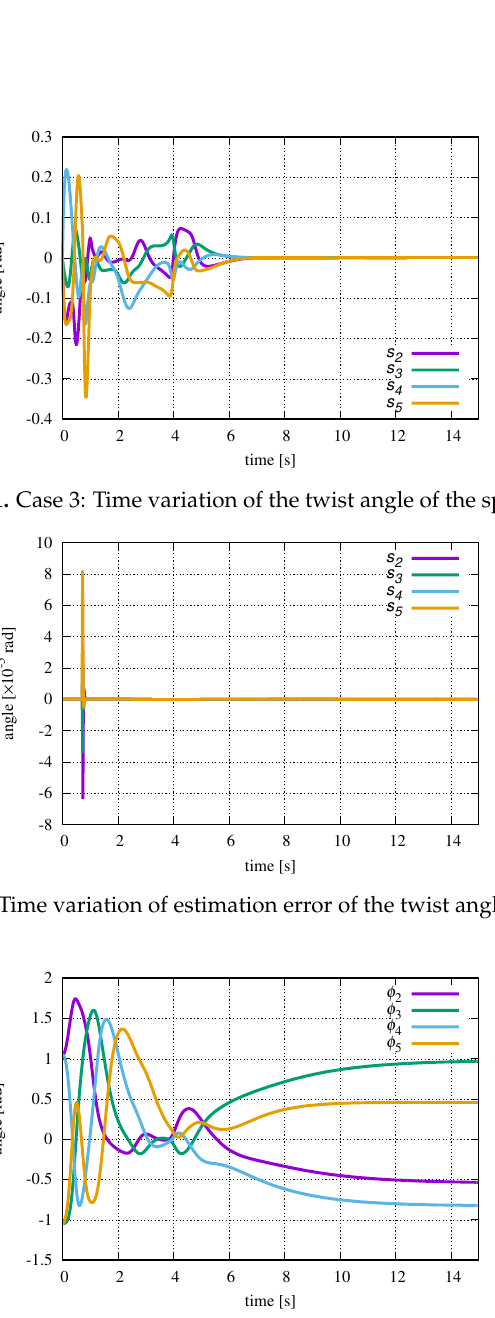
Figure 33. Case 3: Time variation of the relative angles.